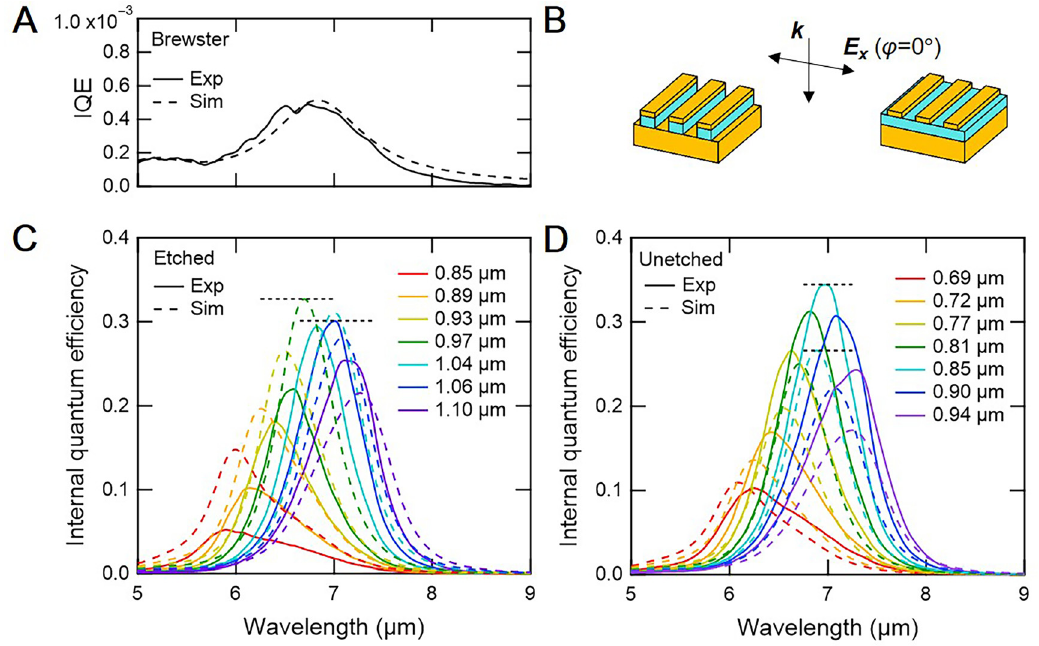
Figure5: Experimentalinternalquantumefficiency(IQE)andsimulatedabsorptionefficiencyinthestripedetectors (x -polarized).A)Brewster- angle detector experimental IQE and fi t used to calculate the dielectric function for the quantum well. B) The illumination scheme shows incidentlight( k )andpolarization( x )forall fi gures.ExperimentalIQEandsimulatedlightabsorptionforC)unetchedandD)etchedcavities.The horizontal black dotted lines correspond to the maximum absorption in the experimental and simulated